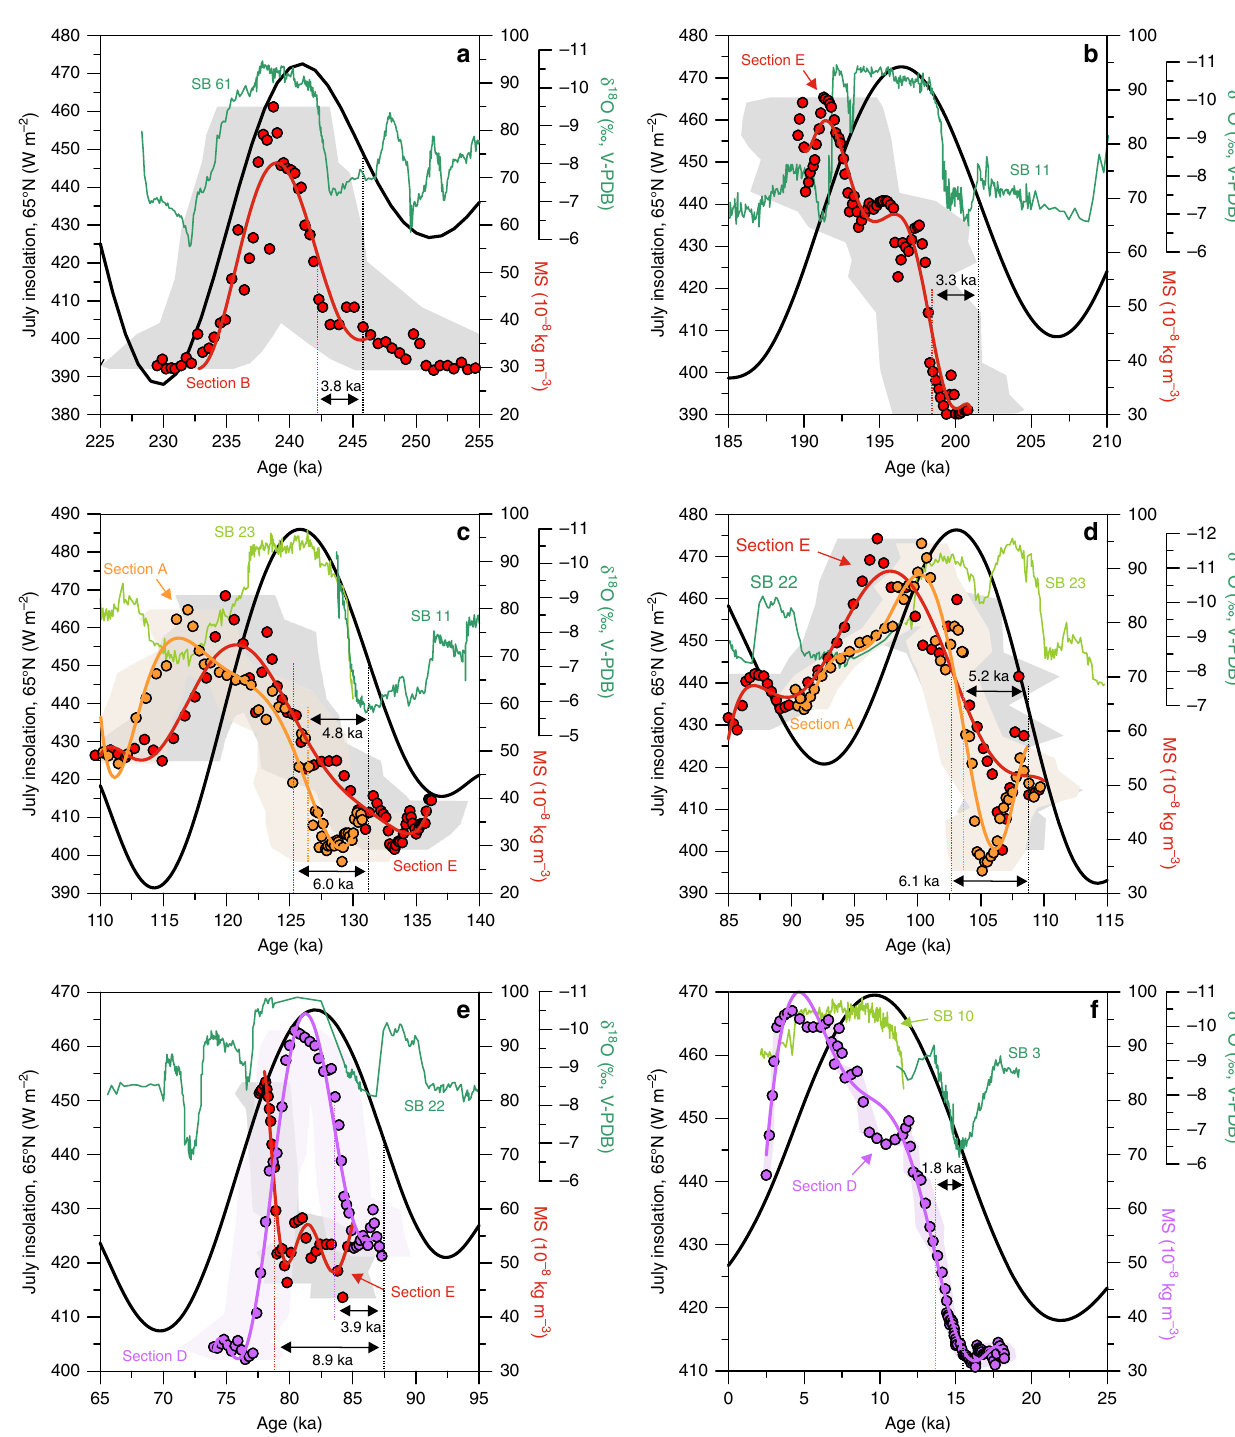
Fig. 4 Comparison of insolation with East Asian Summer monsoon proxy time series back to ~250 ka. Records shown include 65°N July insolation 22 (black curve), the U-Th-dated Sanbao (SB) cave δ 18 O records 34, 85 (green lines) and the OSL/pIRIR-dated loess/soil magnetic susceptibility (MS) records at Jingbian (red/orange/mauve symbols and lines) for a MIS 8/7, b MIS 7/6, c MIS 6/5, d MIS 5/4, e MIS 5 and f MIS 2/1 transitions. The red/orange/ mauve curves represent fi tted polynomials to the MS data sets. Lag calculations for the MS records are given against 65°N July insolation and lag values are speci fi ed for the in fl ection points. Shaded area behind the MS data indicates 1 s.d. age model